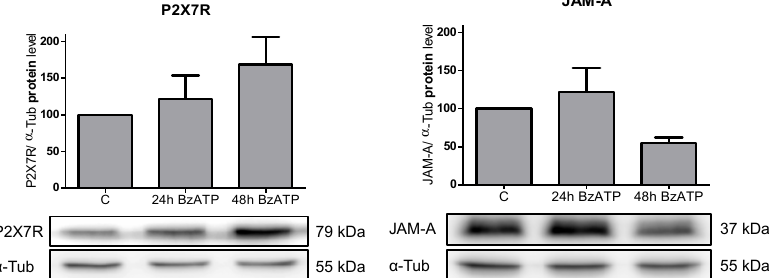
Figure 5. Analysis of protein levels in alveolar epithelial cell line E10 after treatment with 150 µM BzATP. Cells were treated with BzATP for 24 h and 48 h. For SDS-PAGE, equal protein amounts of cell lysates were used and analyzed by Western blot with antibodies against P2X7R, JAM-A, and α -Tub. Untreated cells were used as the control and normalized to 100%. Protein levels were normalized to α -Tub and are shown as the mean ± SEM ( n = 3) in relation to the control. One representative blot is pictured. P-values: P2X7R 0.1667 and JAM-A 0.1048.